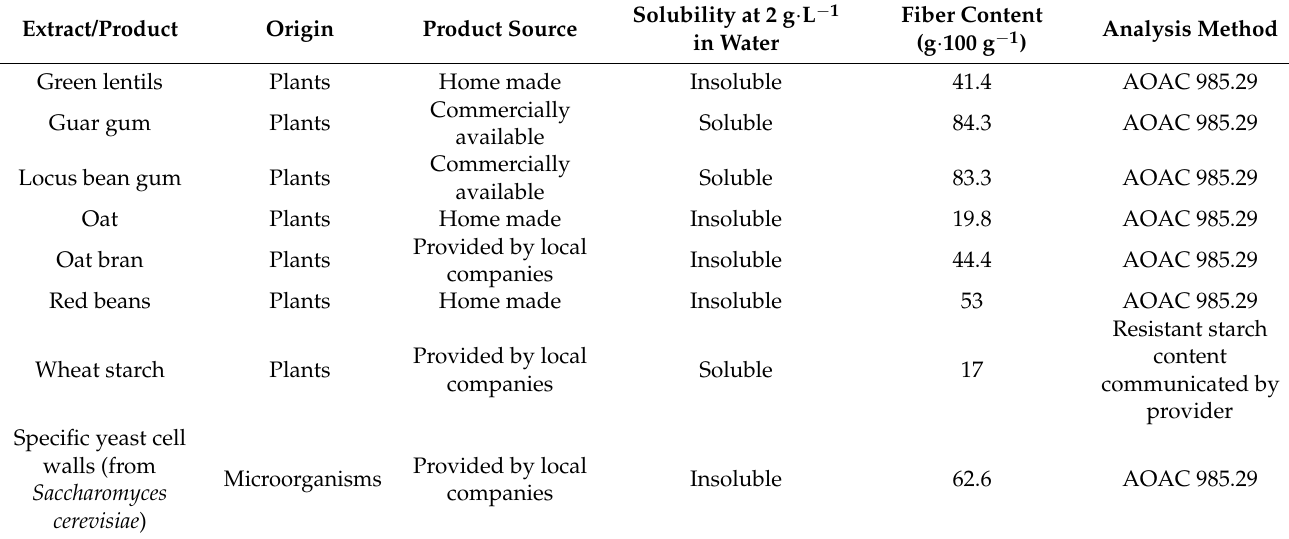
Table 1. Characteristics of dietary-fiber-containing products. The product origin and source, their solubility at 2 g · L − 1 in water, their fiber content, and the analysis method used for determining fiber content are indicated in the